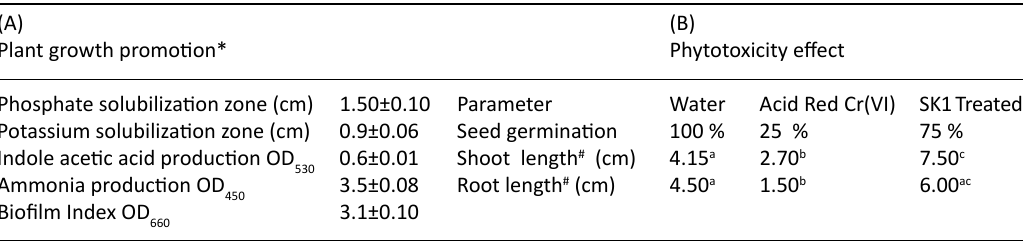
Table 3. In vitro plant growth promotion by K. pneumoniae SK1 (A) and Phytotoxicity effect of untreated and treated 100 µg/ml AR+Cr(VI) on seed germination and growth of Triticum aestivum plant